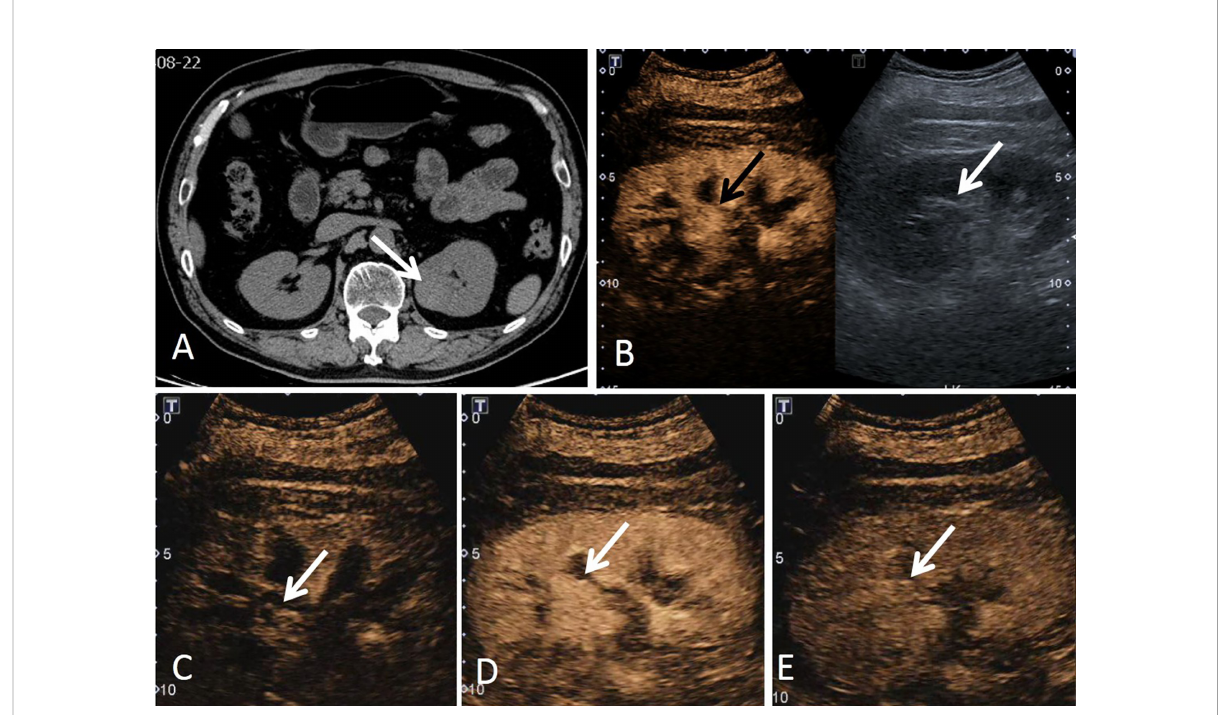
FIGURE 4 A 69-year-old man had a ccRCC in the left kidney with the size of 2.9 × 2.1 cm. (A) Non-enhanced CT scan showed a mass (white arrow) that was poorly demarcated from the renal pelvis and surrounding vessels. (B) According to the position displayed on CT, the simultaneous display mode of CUS (right) and CEUS (left) was performed, CEUS showed a suspicious mass with hyperenhancement (black arrow), but it was not clear on CUS (white arrow). (C) On CEUS imaging, the contrast agent entered the mass (white arrow) synchronously with the adjacent renal cortex. (D) The tumor showed homogeneous enhancement, and the enhancement intensity was slightly higher than that of the adjacent renal cortex (white arrow). (E) CEUS imaging showed that the tumor had a slow-out pattern (white arrow) compared to the renal cortex.